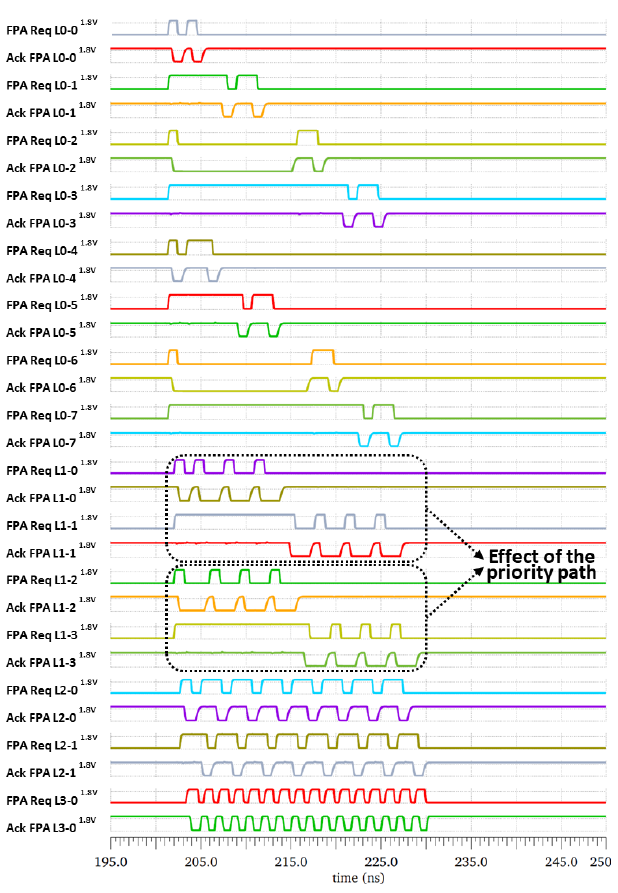
Figure 9. FPA tree Cadence simulation results. The effect of the priority path is highlighted with the output of the second row of the FPA the request signal L1-0 and L1-1. The L1-0 data are extracted first by the next L2-0 FPA